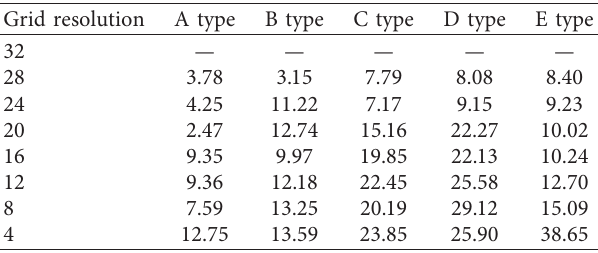
Table 3: Results of CV(RMSE) in each case.